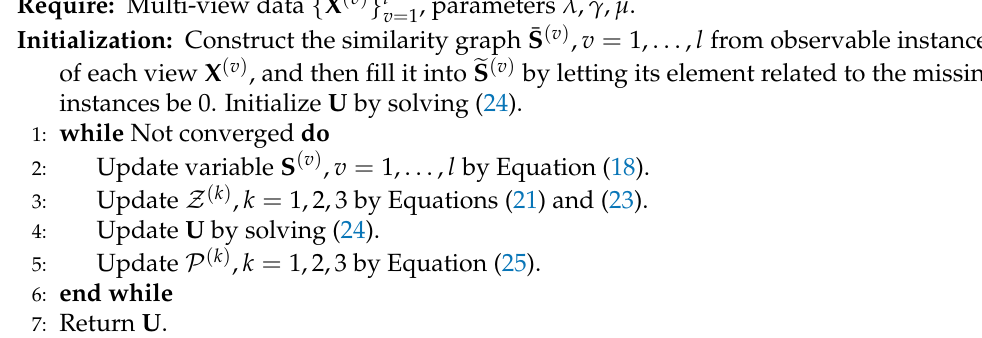
Algorithm 1 Incomplete multi-view clustering via low-rank graph tensor completion (IMC-